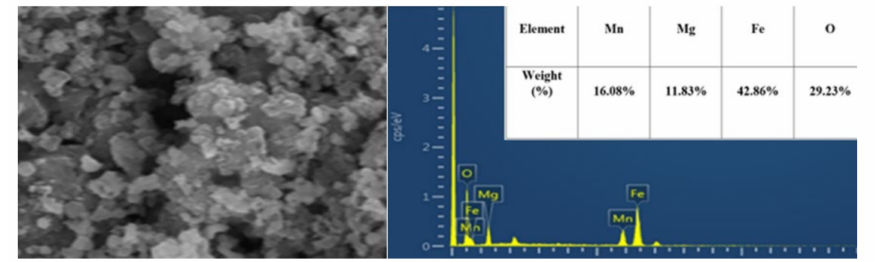
Figure 2. SEM-EDS of H-4